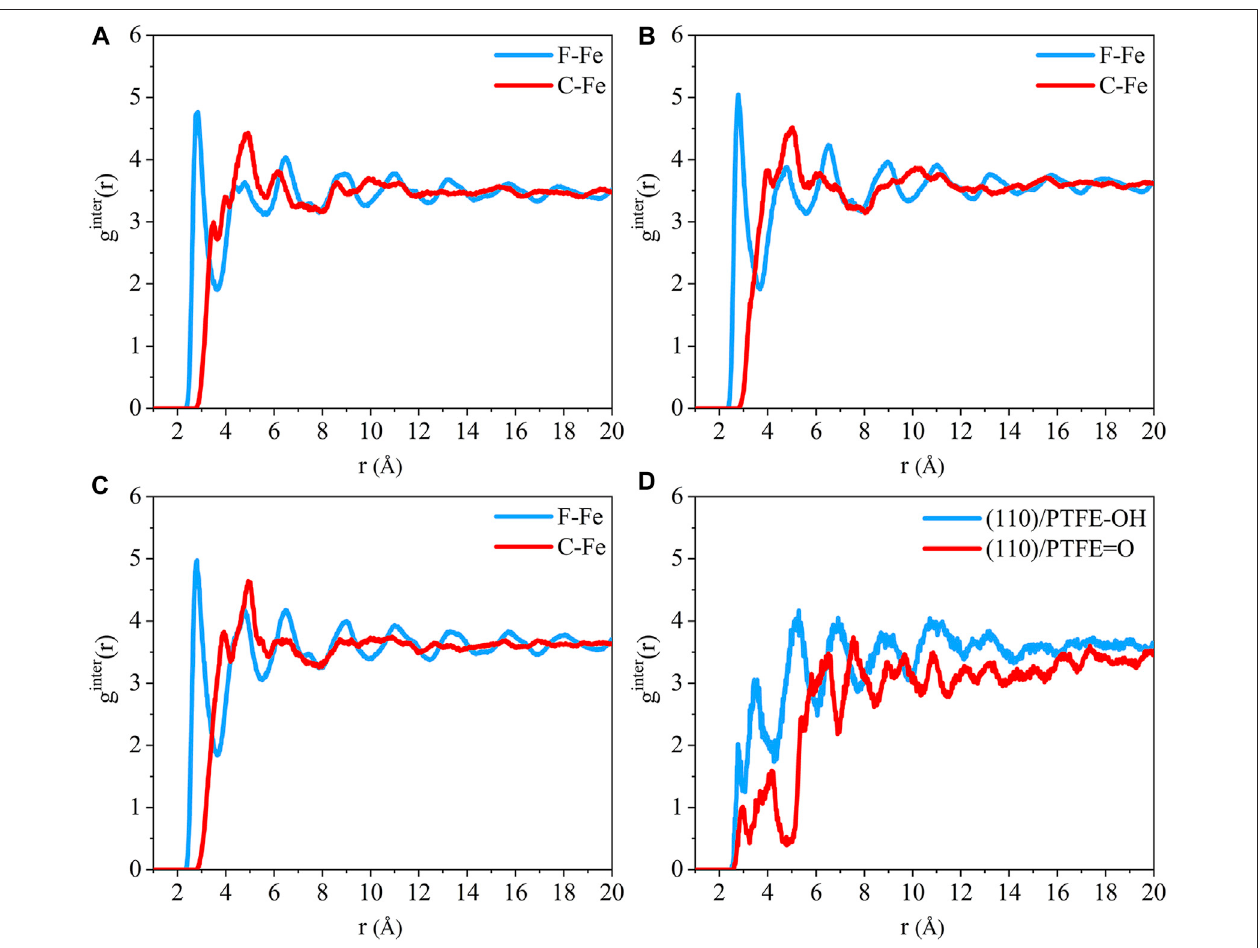
FIGURE 8 | Radial distribution function of the F-Fe and C-Fe pairs for the (A) (110)/PTFE-S, (B) (110)/PTFE-OH, and (C) (110)/PTFE (cid:2) O interface systems. Radial distribution function of the (D) O-Fe pairs for the (110)/PTFE-OH and (110)/PTFE (cid:2) O interface systems.